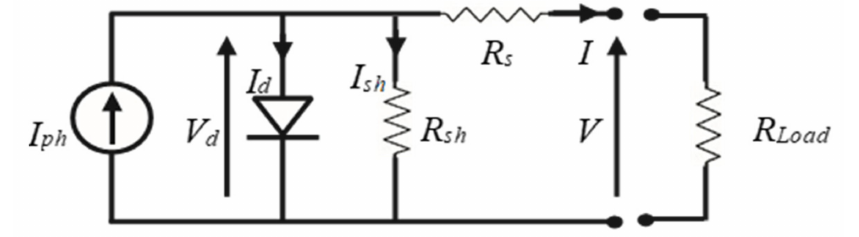
Figure 1. Electrical equivalent of the solar cell.